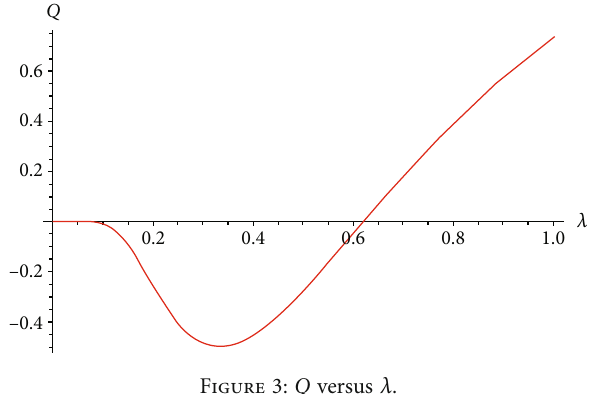
Figure 3: Q versus λ .